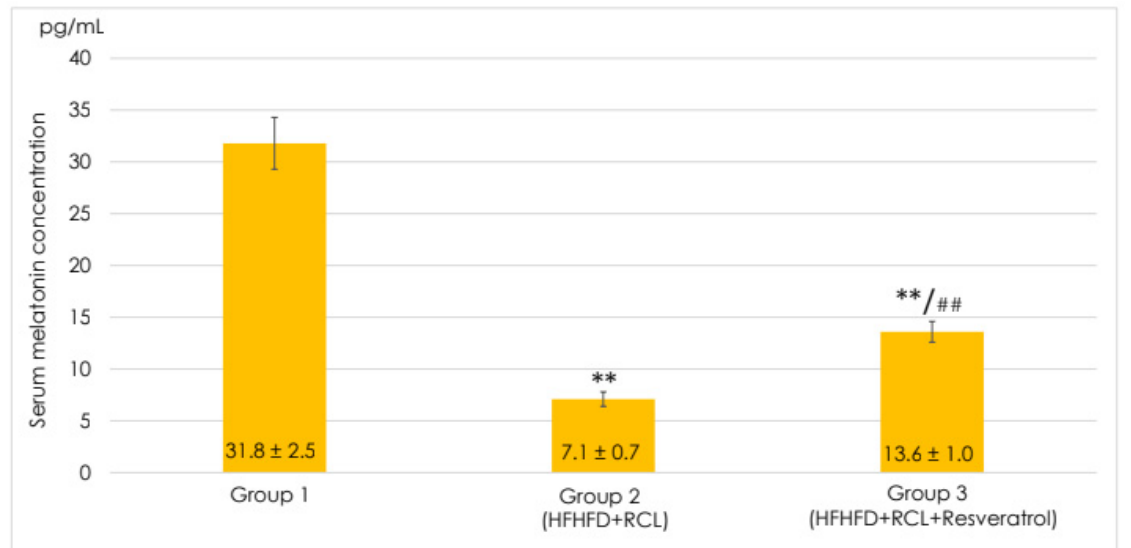
Figure 1. Serum Melatonin, n = 7. Values were expressed as Mean ± SEM. Control, HFHLD (high-fructose high-lipid diet) + RCL (round-the-clock lighting), and HFHLD + RCL + Resveratrol; ** p < 0.001 is significant compared to group 1; ## p < 0.001 is significant compared to group 2.